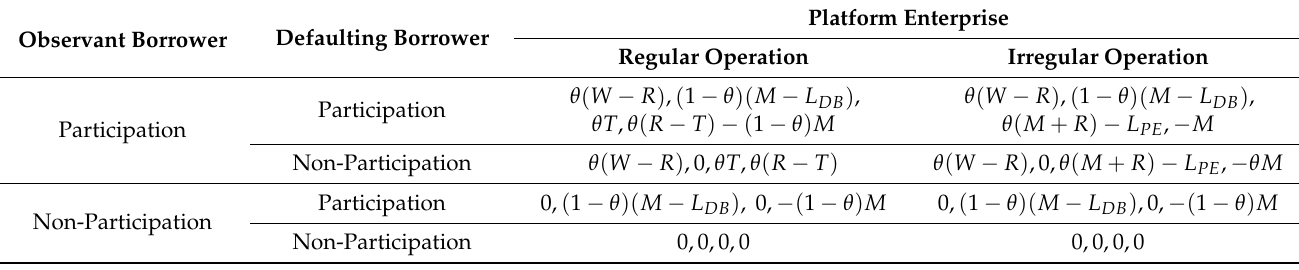
Table 2. Payoff matrix of the peer-to-peer lending platform of scenario 1 (when the investor chooses the IN1 strategy). Observant Borrower Defaulting